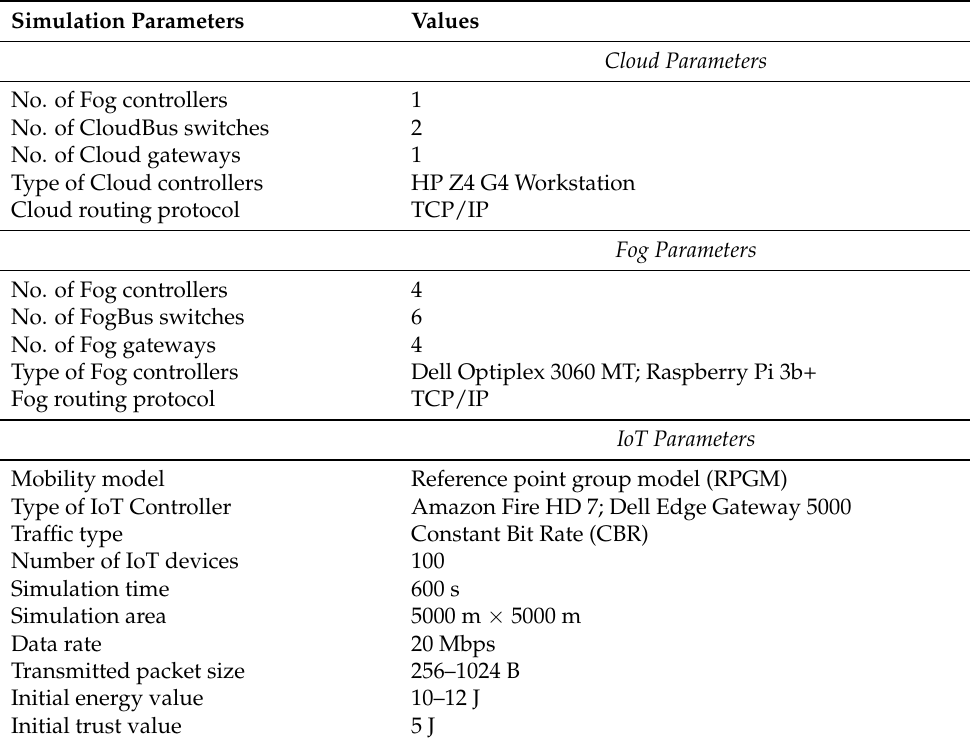
Table 6. Parameters of the simulation environment (device